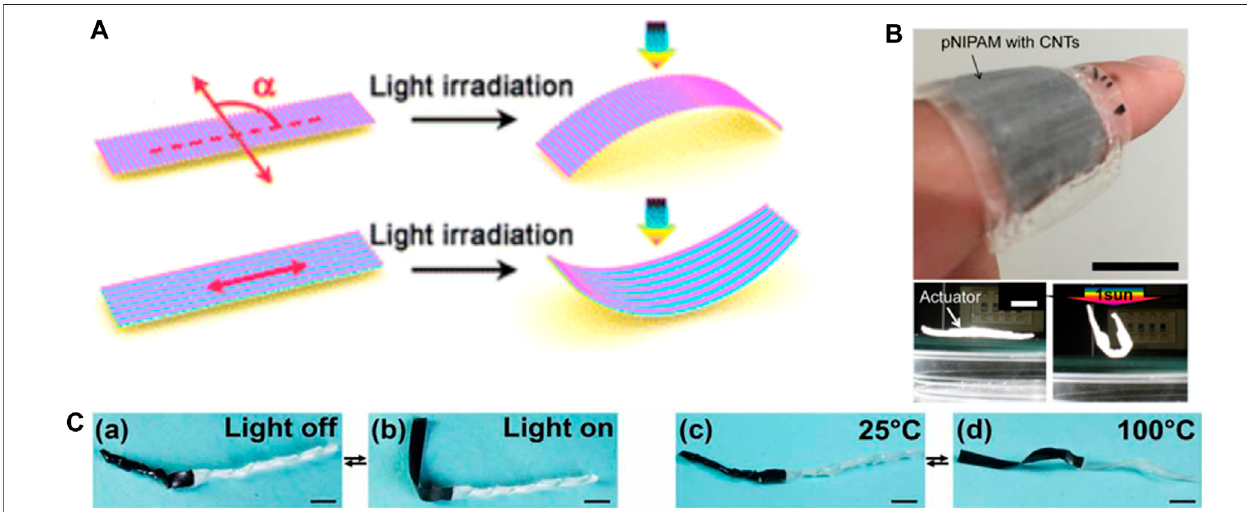
FIGURE 8 | (A) Schematic illustration of the apheliotropic and phototropic bending of the composite strips with different aligned directions of smart actuator. Reproduced from Deng et al. (2015) with permission of American Chemical Society. (B) Demonstrations of the PNIPAM actuators stimulated by the human skin temperature and sunlight. Reproduced from Yamamoto et al. (2015) with permission of American Chemical Society. (C) Schematic showing of an area-selective reversible multiresponsive actuator. Reproduced from Zhang Y. et al. (2020) with permission of American Association for the Advancement of